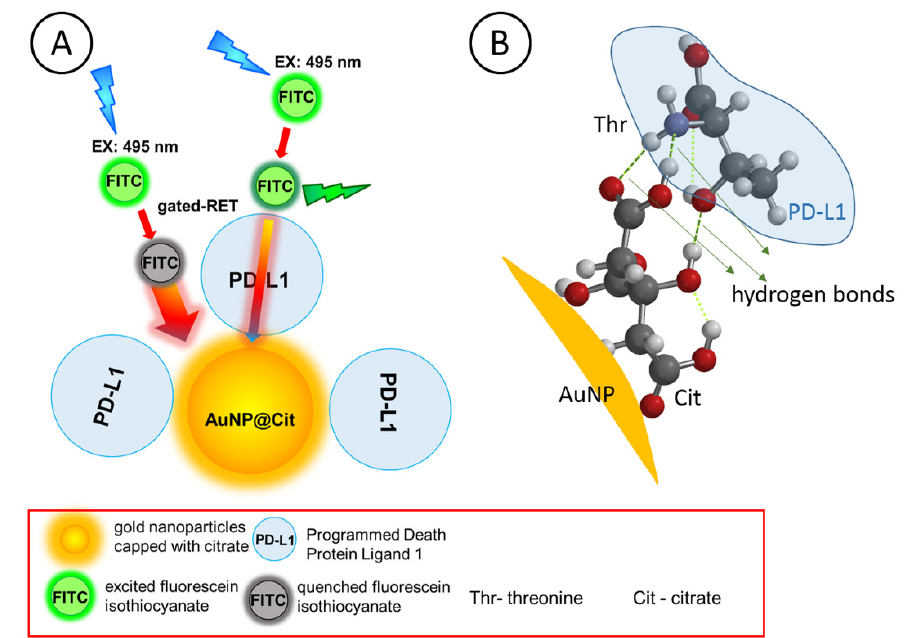
Figure 4. ( A ) Principle of gated resonance energy transfer (gRET) (drawn not to scale); ( B ) Scheme of the interaction of adsorbed citrate (Cit) with threonine (Thr) amino acid of the PD-L1 molecule with the formation of hydrogen bonds.